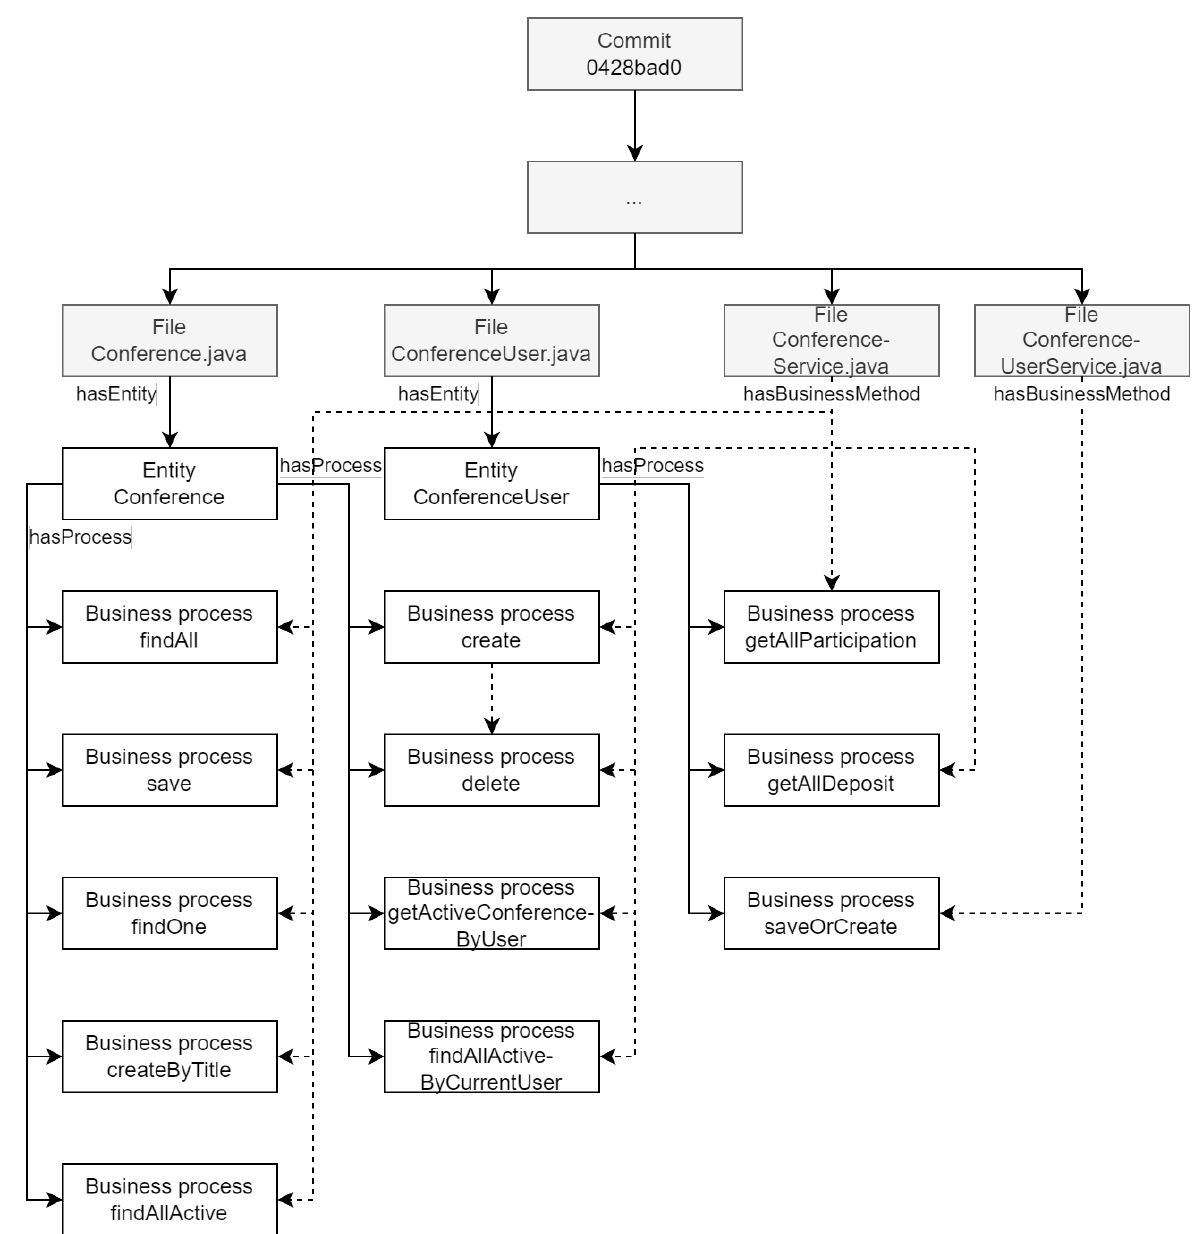
Figure 6. Example of the D B representation